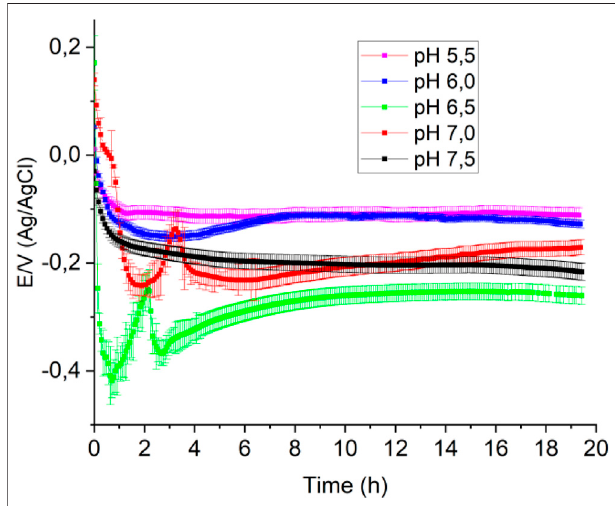
FIGURE 2 | Open circuit potentials obtained in 100 ml of Mueller-Hinton broth with 1 ml of bacterial culture at different pHs in a previously saturated with O 2